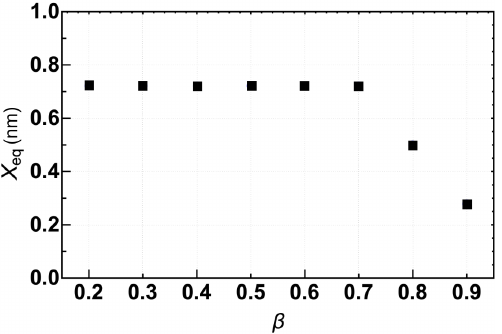
Figure 2. x -component of equilibrium state, (cid:126) R eq , as a function of β at J =